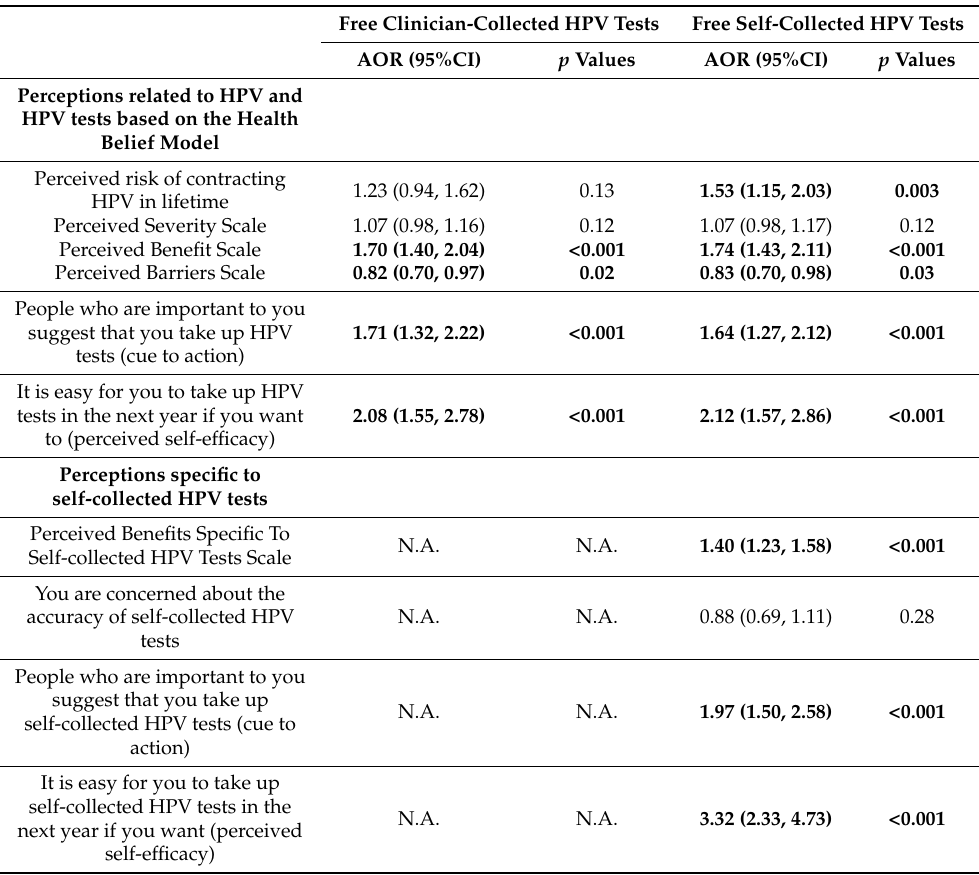
Table 4. Factors associated with behavioral intention to take up clinician-collected and self-collected HPV tests ( n =